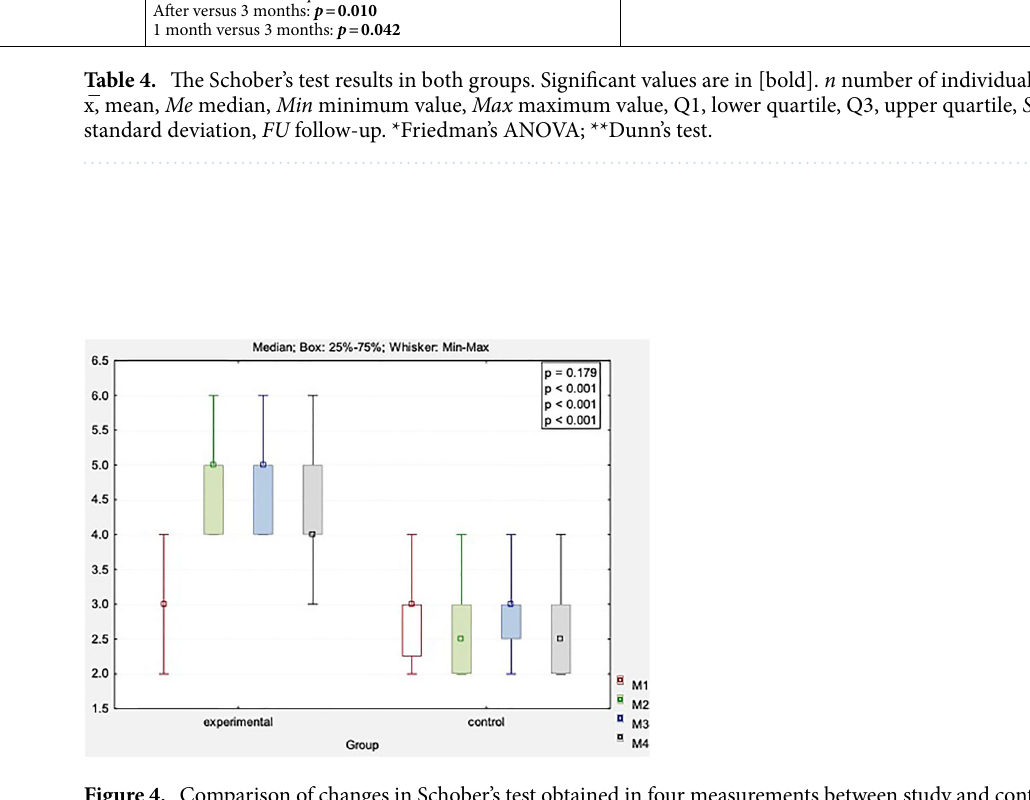
Figure 4. Comparison of changes in Schober’s test obtained in four measurements between study and control group. M1, before treatment; M2, after treatment; M3, 1 month after study; M4, 3 months after